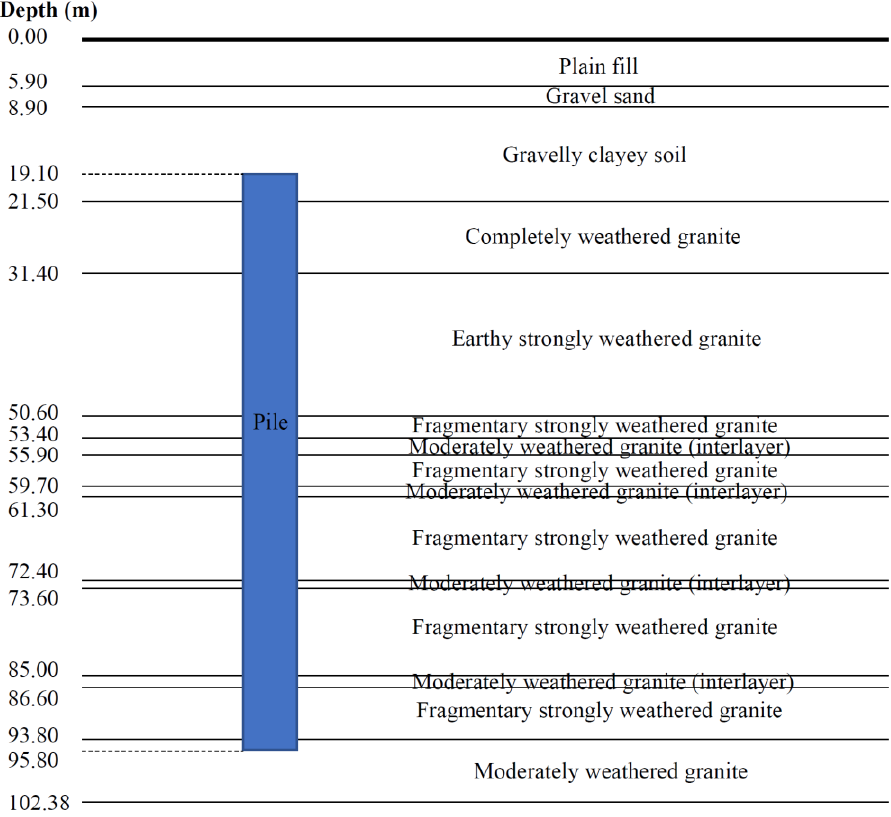
Figure 4. The stratum of Pile A50.